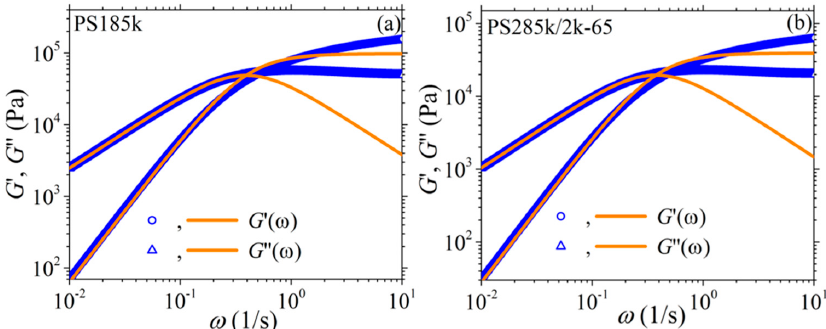
Figure 9. Comparison of the model predictions for the storage and loss moduli with the experimental data of Costanzo et al. [16] for: ( a ) a nearly monodisperse PS melt with M = 185 kDa (PS185k) at 160 ◦ C characterized by τ d = 5.1 s and η 0 = 2.28 × 10 5 Pa.s, and ( b ) a nearly monodisperse PS solution with M = 285 kDa and polymer volume fraction 64.9% (PS285k / 2k-65) at 160 ◦ C characterized by τ and η 0 = 1.04 × 10 5